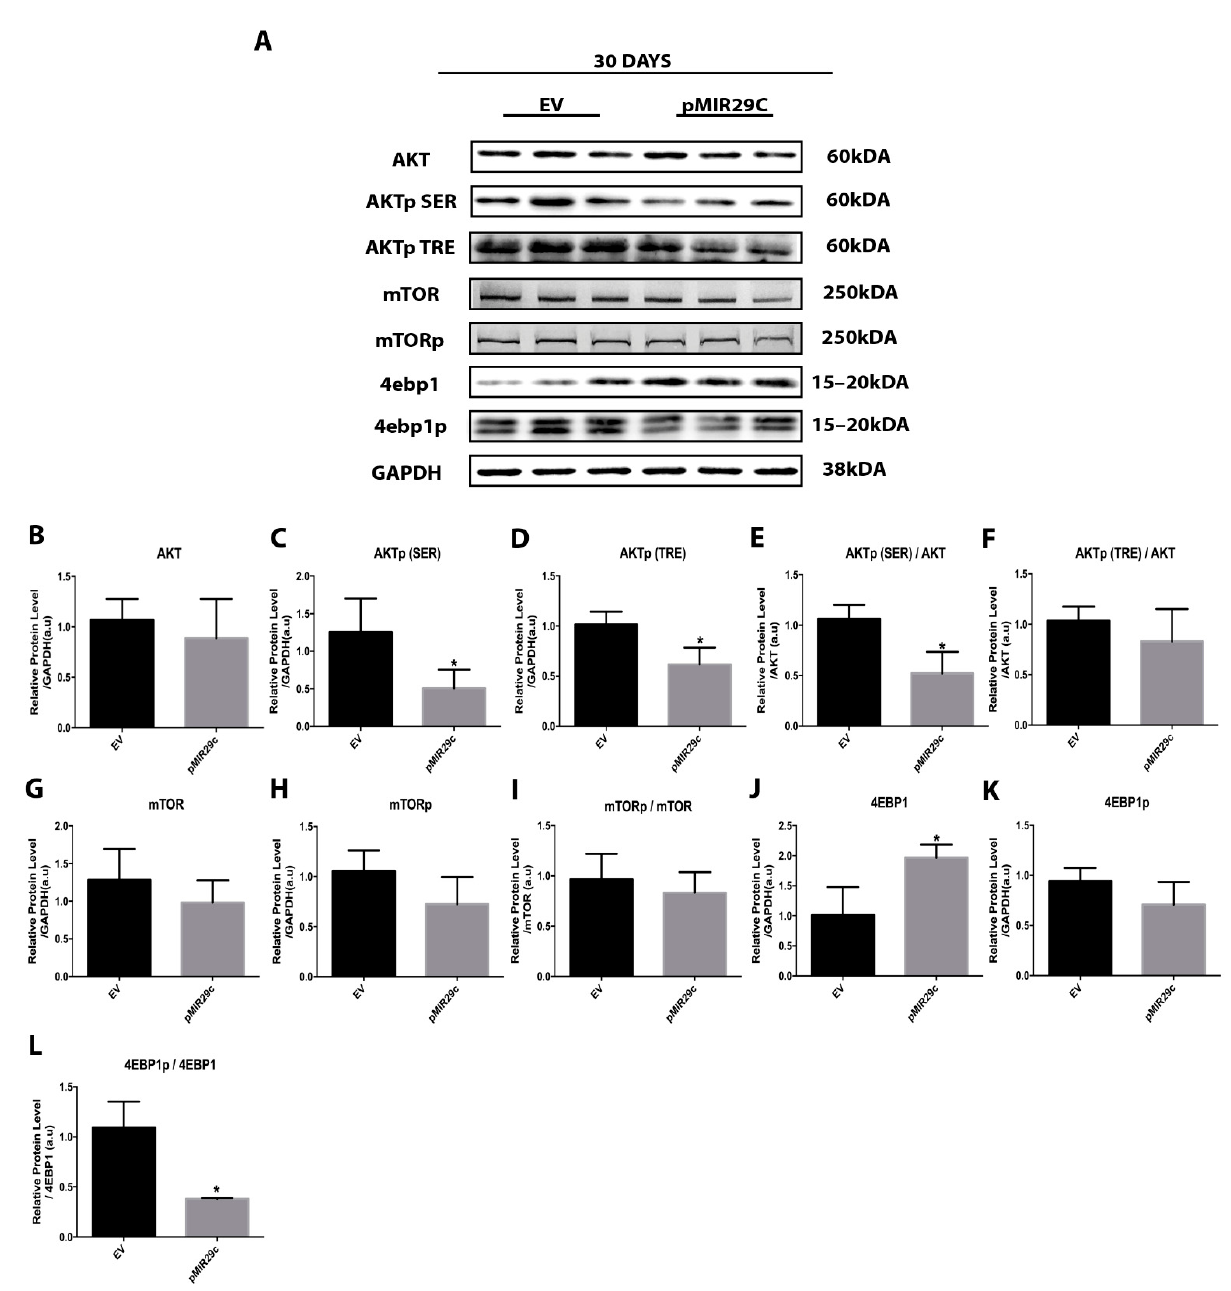
Figure 4. Phosphorylation and total protein involved in AKT/mTOR signaling after 30 days of miR- 29c overexpression. ( A ) Representative bands after 30 days of miR-29c overexpression. Densitome- try analysis of AKT ( B – F ), mTOR ( G – I ), and 4EBP1 ( J – L ) ( n = 5 per group). Data are presented as mean ± SD. Statistical analysis included an unpaired t -test and a Mann–Whitney test. * p < 0.05 vs. EV group.